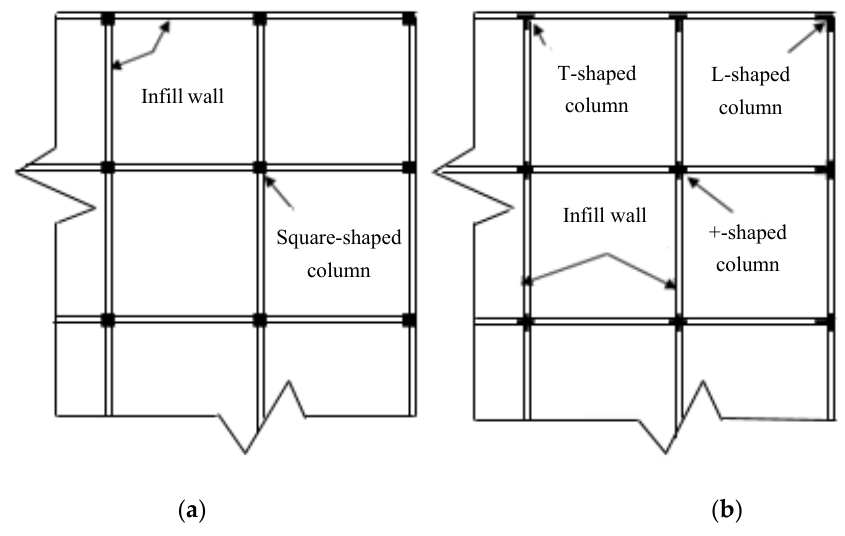
Figure 1. RC frame with: ( a ) Rectangular or square columns, ( b ) special shaped columns.